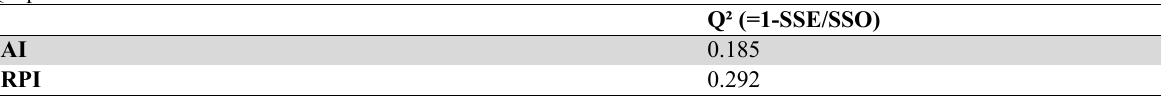
Q square AI 0.185 RPI